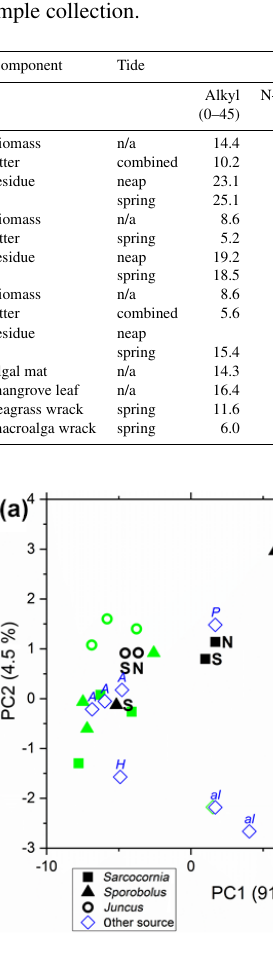
Figure 4. Principal component analysis of MIR spectra with the proportion of variance explained by each component given in parentheses (a) ; spectral loading plots for PC1 (b) and PC2 (c) . S: spring tide samples; N: neap tide samples; H: Hormosira banksii (macroalga) wrack;